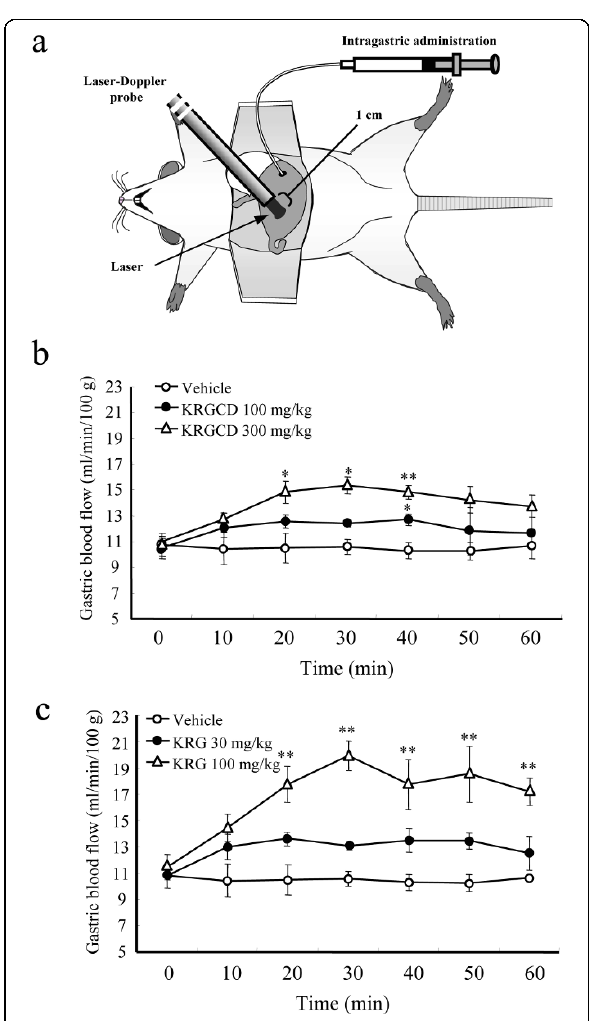
Figure 6 Effects of KRGCD and KRG on the gastric mucosal blood flow . Gastric mucosal blood flow was measured using a laser Doppler flowmeter (a). Effects of KRGCD (b) and KRG (c) on basal gastric mucosal blood flow. n = 3-4 for each group. Each value represents the mean ± SEM. * p < 0.05, ** p < 0.01 vs. control, Dunnett ’ s multiple-range